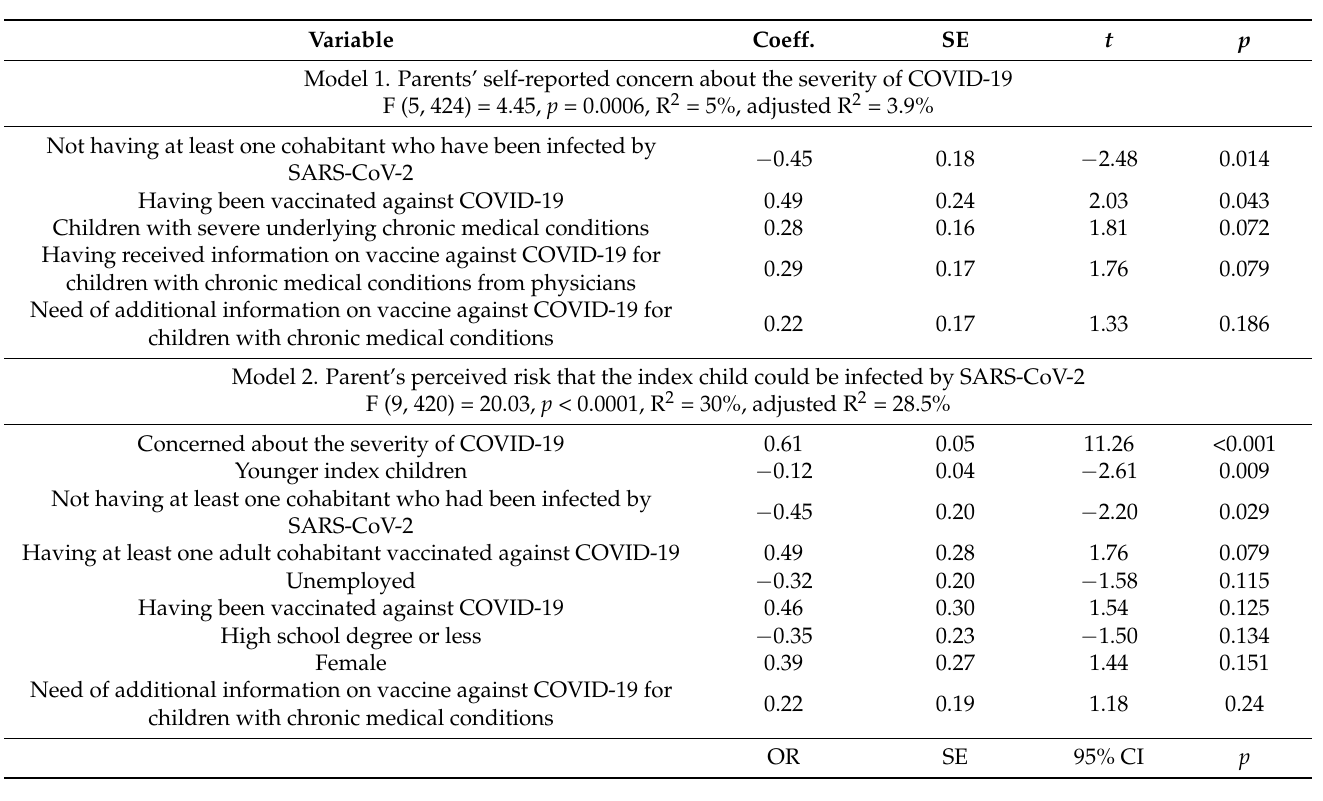
Table 2. Multivariate linear and logistic regression analysis results examining the outcomes of interest according to several explanatory